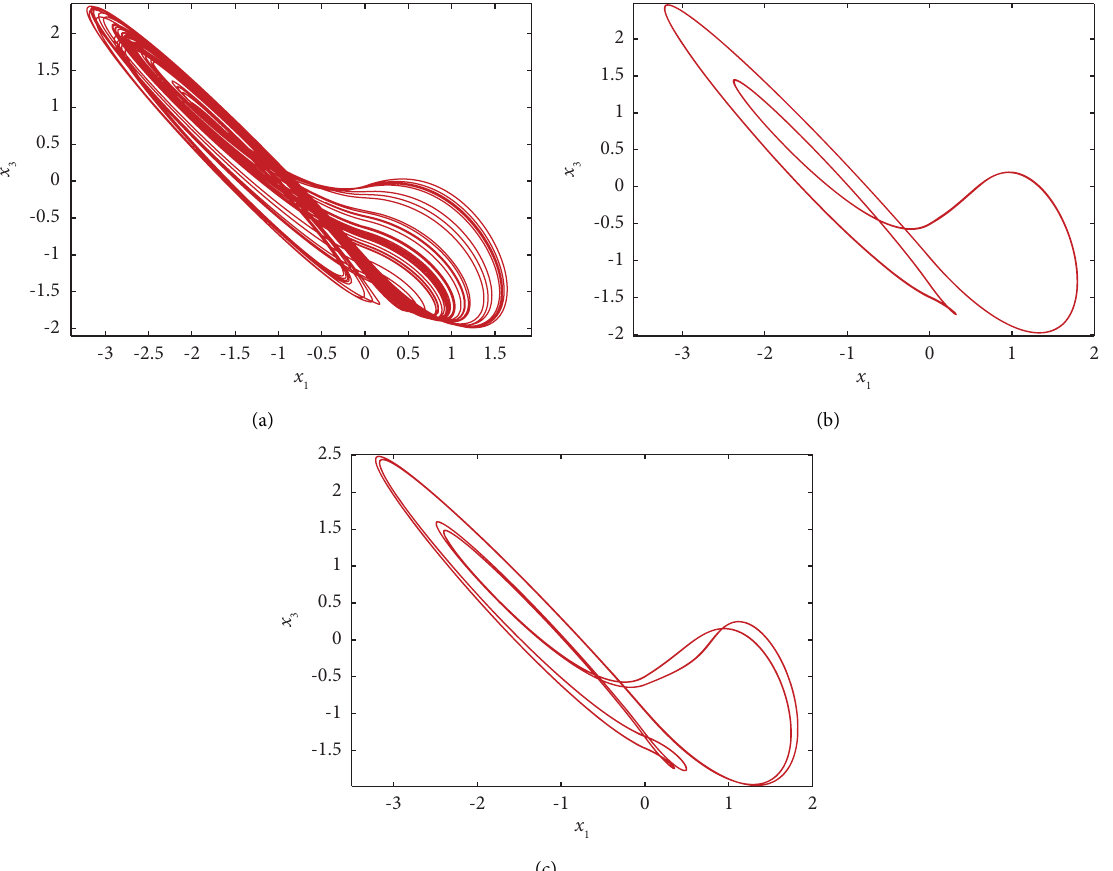
Figure 10: Types of the system phase diagrams with the change of the system initial value x phase diagram; (b) x